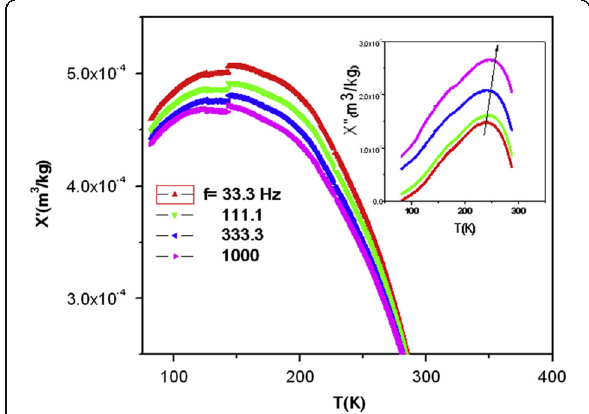
Fig. 21 Ac susceptibility versus temperature for the La 0.8 Sr 0.2 MnO 3 sample (particle size of 20 nm) at different frequencies. Inset is the imaginary part as a function of the temperature at different frequencies. Reproduced with permission of